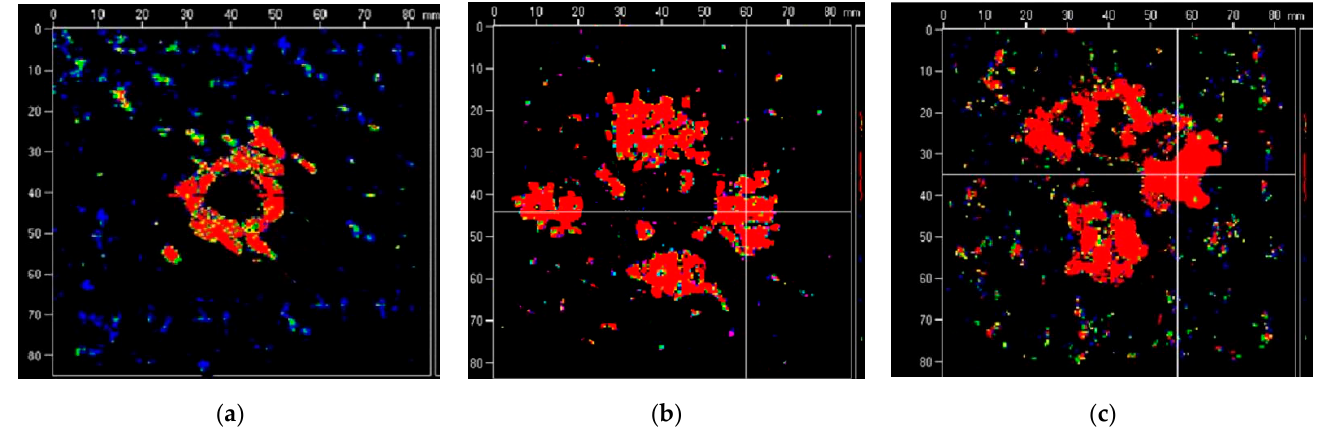
Figure 6. The maximum failure surface and depth of the specimen with different thickness: ( a ) the fourth layer, 1.25 mm, ( b ) the ninth layer, 3.25 mm, ( c ) the seventh layer, 5.10 mm.